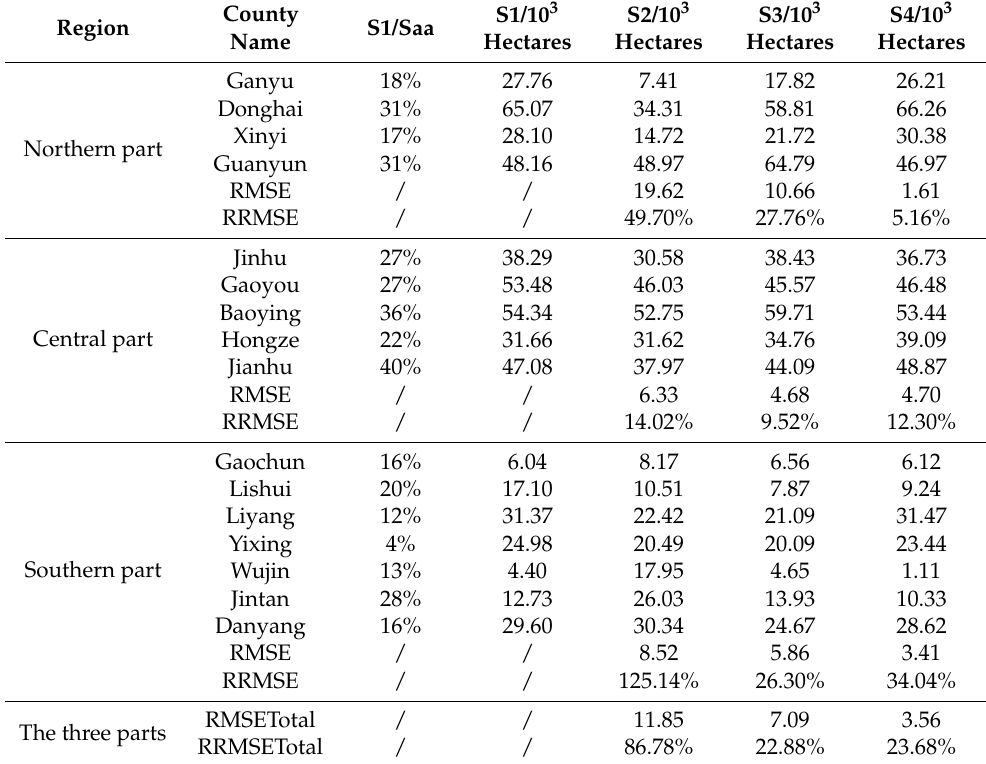
Table 2. Rice area extraction results in different parts of the target region based on different